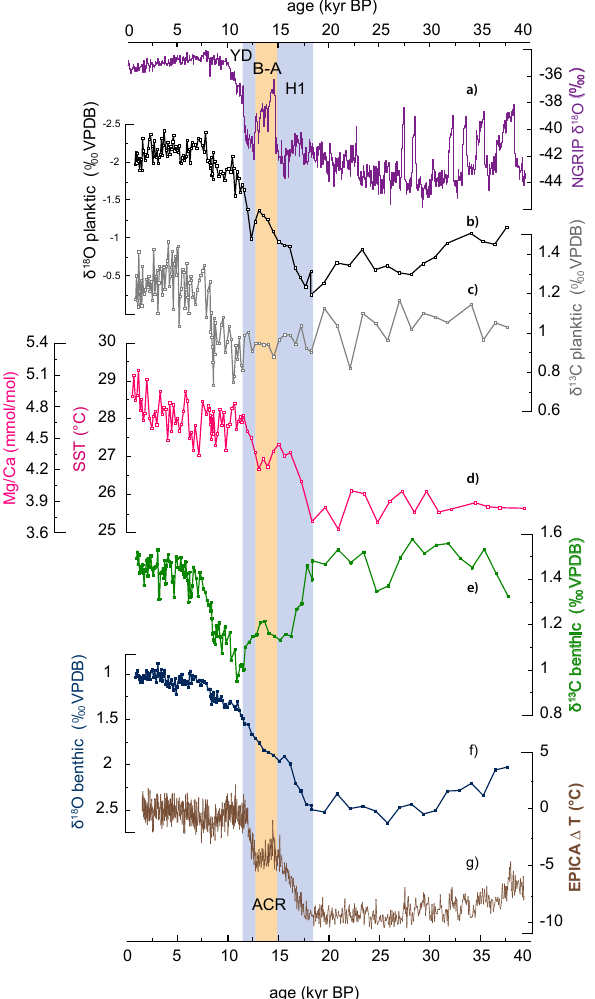
Fig. 3. Comparison of ice core records with data of GeoB12615-4 spanning the last 40kyr. (a) NGRIP stable oxygen isotopic record (Andersen et al., 2004). (b) δ 18 O planktic record of GeoB12615-4 (‰ VPDB). (c) δ 13 C planktic record of GeoB12615-4 (‰ VPDB). (d) Shell Mg/Ca ratio of planktic foraminifera (mmolmol − 1 ) and reconstructed SST record of GeoB12615-4 ( ◦ C). (e) δ 13 C benthic record of GeoB12615-4 (‰ VPDB). (f) δ 18 O benthic record of GeoB12615-4 (‰ VPDB). (g) EPICA Dome C ice core tempera- ture estimates (Jouzel et al.,